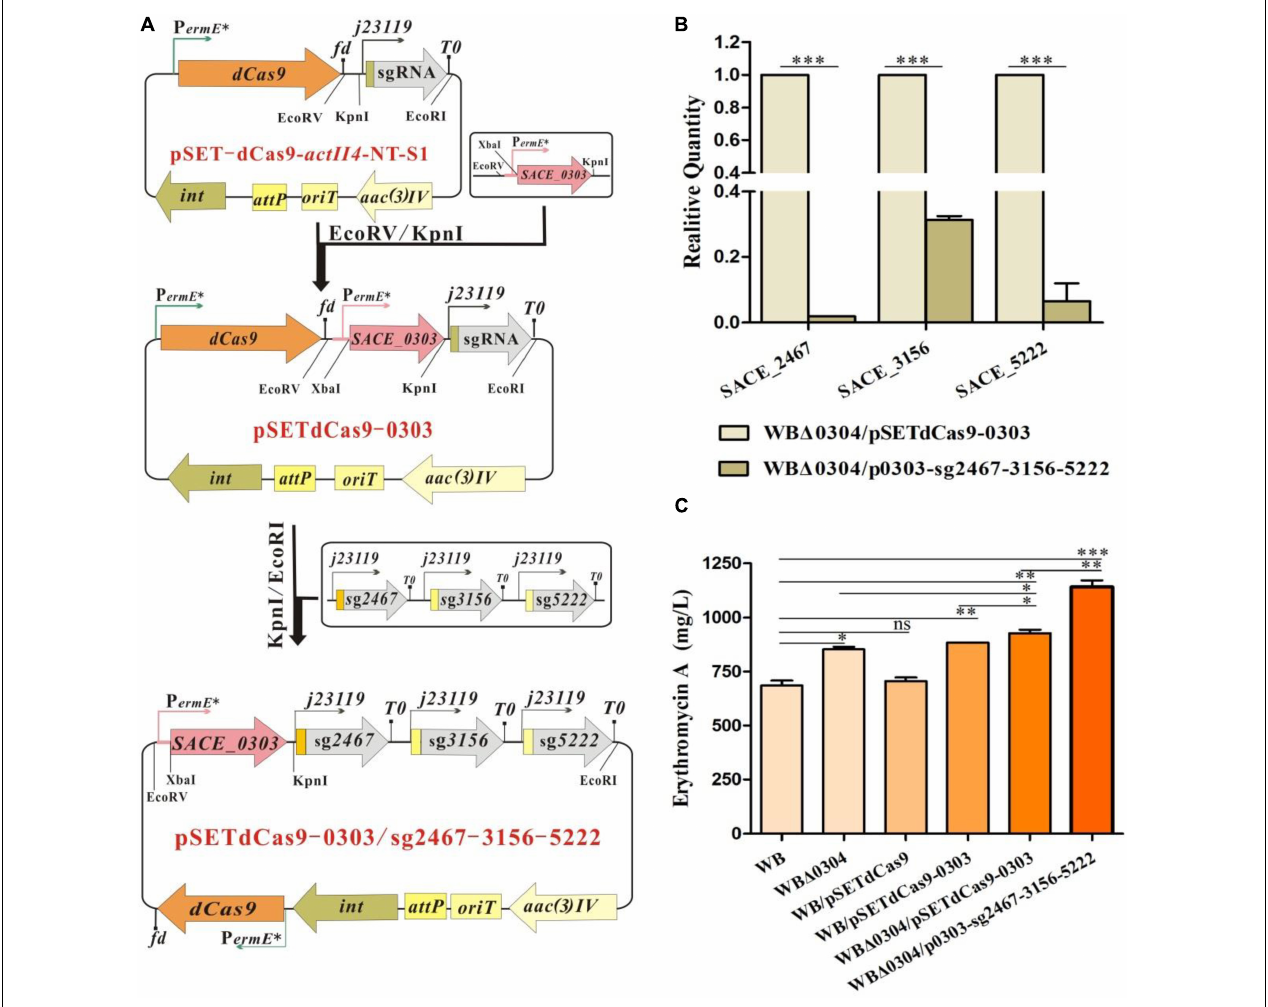
FIGURE 7 | Multiplex engineering of SACE_0303-mediated regulatory system in WB. (A) Schematic construction of pSET-dCas9 - 0303/sg2467-3156-5222. (B) Transcriptional assays of SACE_2467 , SACE_3156 , and SACE_5222 in WB (cid:49) 0304 /pSETdCas9-0303 and WB (cid:49) 0304 /p0303-sg2467-3156-5222. (C) Er-A yield in WB and its derived mutants. Error bars (B,C) : SD from triplicate experiments. Statistical notations (B,C) : ns, not significant; ∗ p < 0.05, ∗∗ p < 0.01, ∗∗∗ p <